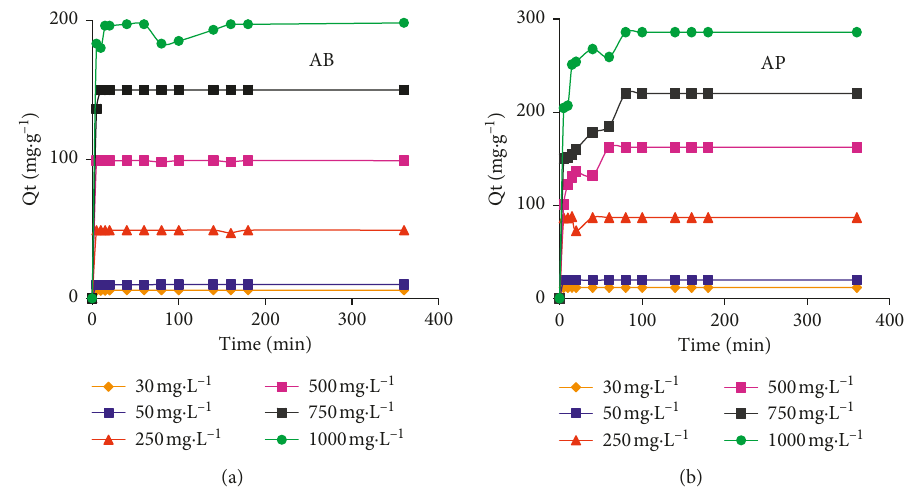
Figure 6: Influence of initial dye concentration variation on adsorption efficiency.